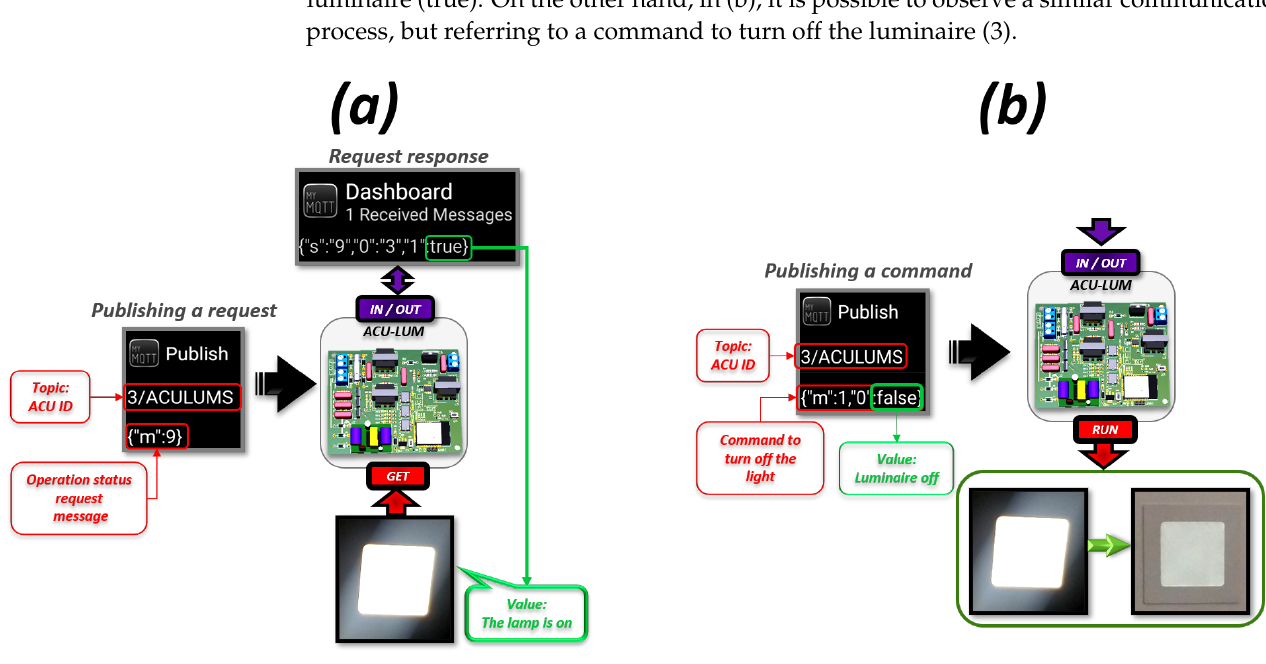
Figure 13. Message exchange processes for validation of DRFs to obtain the operating status ( a ) and on/off control ( b ) of the